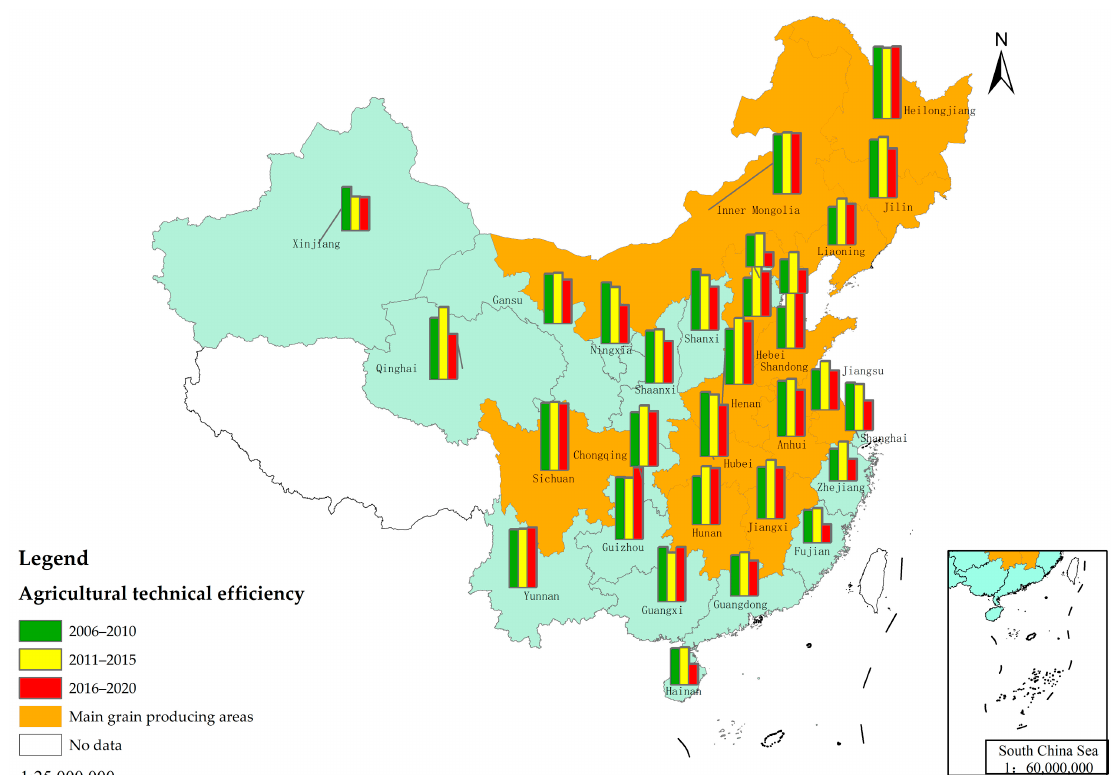
Figure 7. The distribution map of agricultural technology